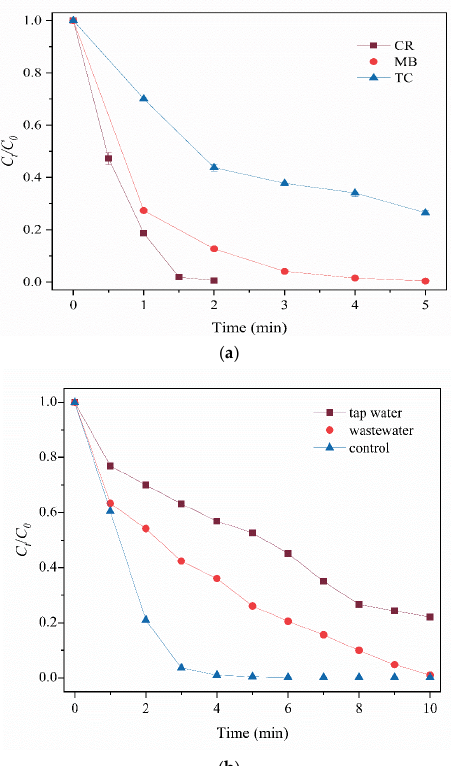
Figure 11. Degradation of different pollutants in the CM/g-C3N4/PMS system ( a ) and RhB removal in different water matrixes ( b ). Reaction conditions: [PMS] = 1.0 mM, [CM/g-C3N4] = 0.30 g/L, [RhB/CR/MB/TC] = 10.0 mg/L, 25 °C.